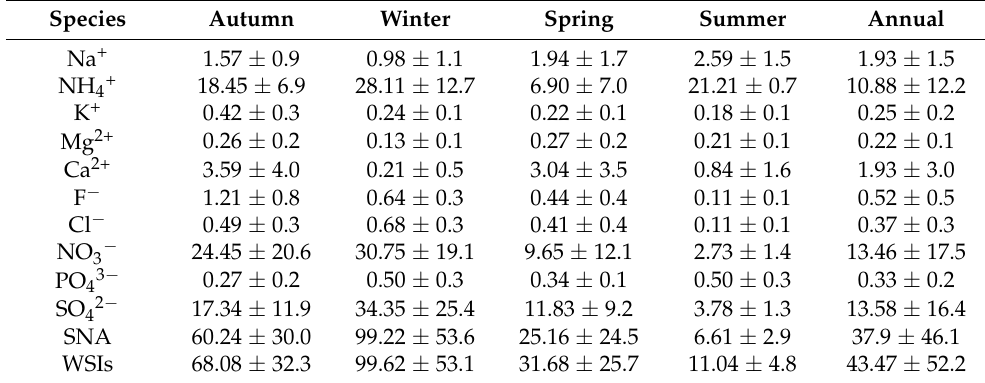
Table 1. The seasonal and annual mean concentrations of water-soluble ions (mean ± SD; unit: µ g/m 3 ). Species Autumn Winter